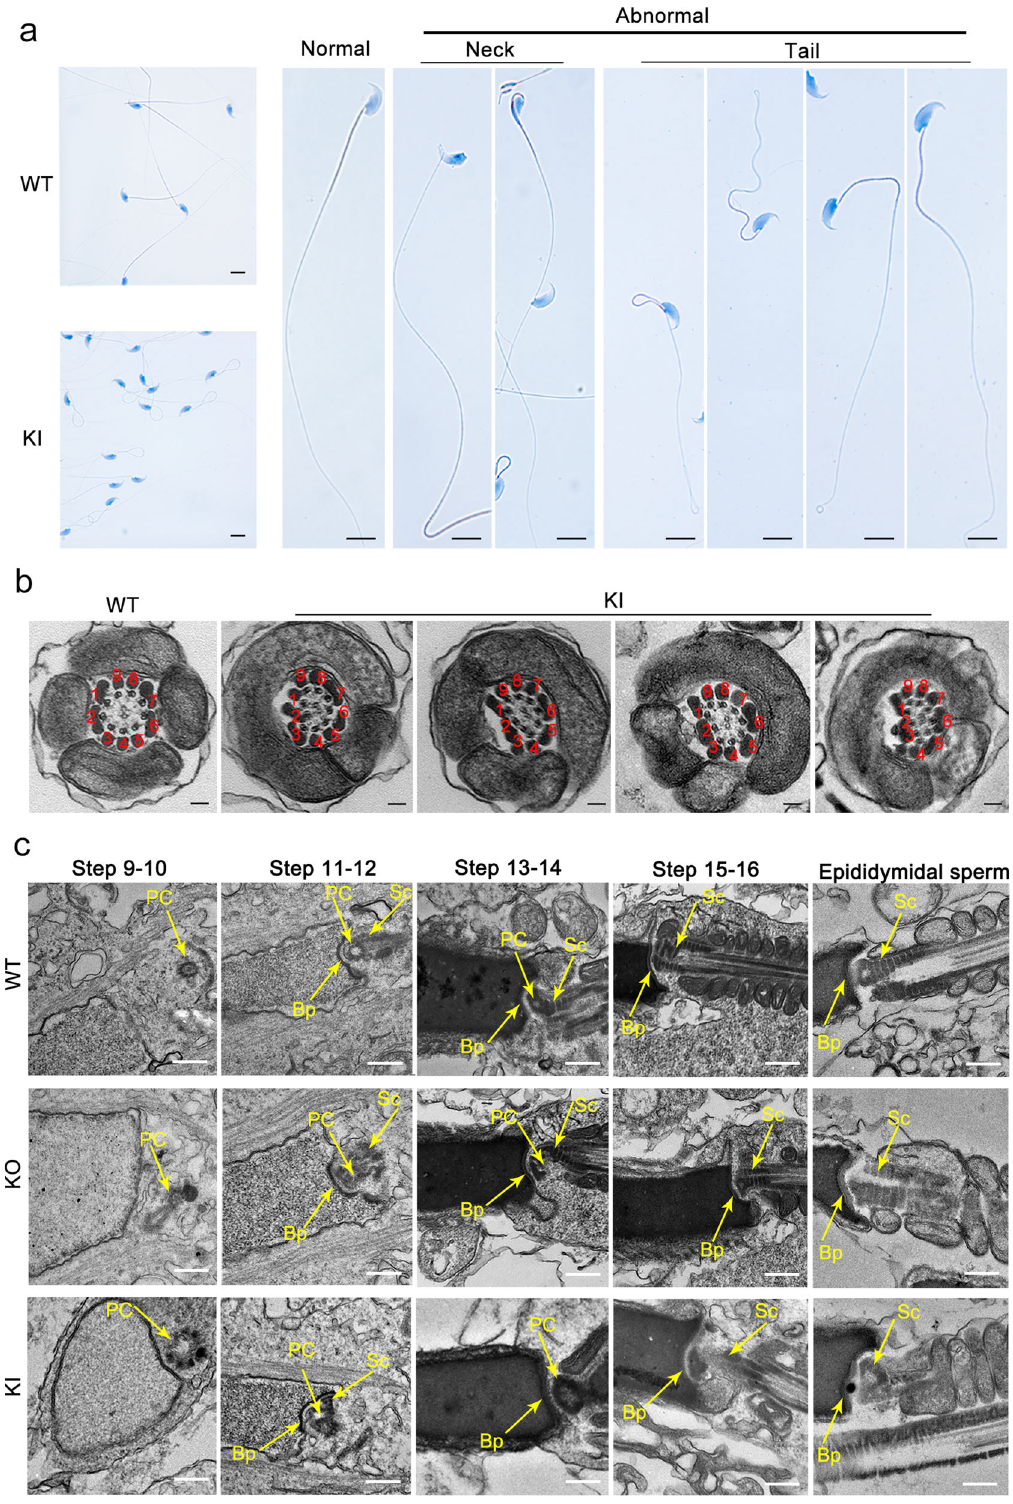
Fig. 6 Multiple defects are observed in spermatozoa from male homozygous Cep128 KI mice. a Male homozygous KI mice showed hyperplasia of sperm fl agella ( n = 3 biologically independent WT mice or KI mice; scale bars, 20 µ m). b Dislocated arrangements of MTDs 1 ‒ 3 and ODFs 1 ‒ 3 were exhibited in the majority of the midpieces. ODF outer dense fi bers, MTD peripheral microtubule doublets. ( n = 3 biologically independent WT mice or KI mice; scale bars, 150 nm). c Impaired development of the connecting piece during spermiogenesis in male homozygous Cep128 KO and KI mice. In spermatid steps 9 – 14, PCs with incomplete structure were present in both male homozygous KO and KI mice. Signs of defective Sc formation were occasionally visible in spermatids from male homozygous KI mice, but not in KO mice. In contrast, the Bp was almost normal in both male homozygous KO and KI mice. PC proximal centriole, Sc segmented column, Bp basal plate. ( n = 3 biologically independent WT mice, KO mice or KI mice; scale bars, 500 nm).